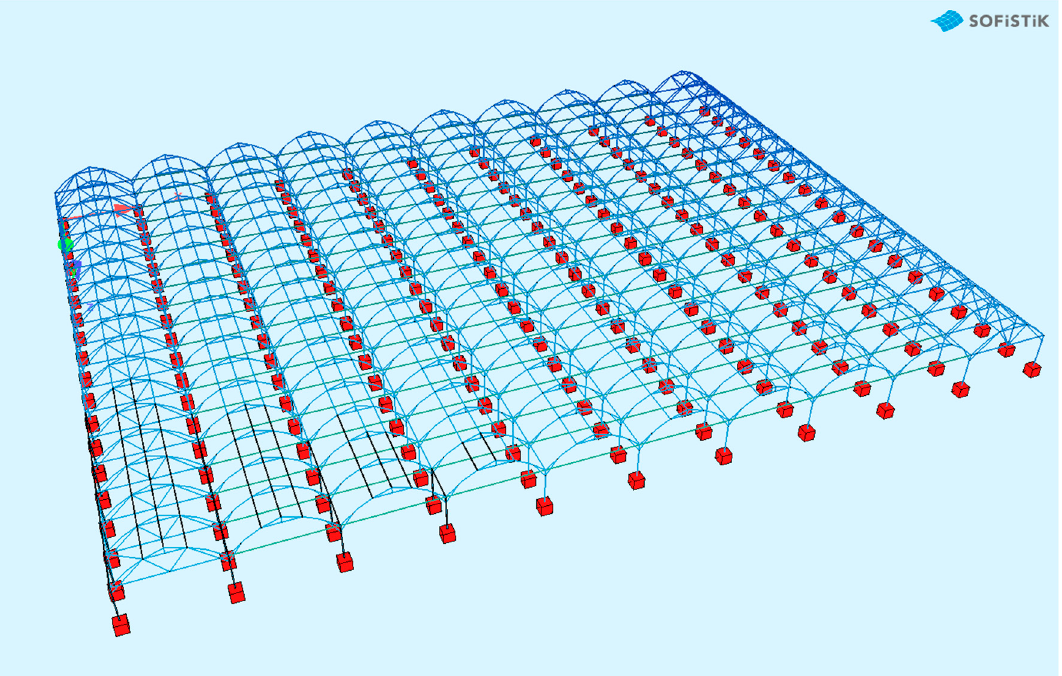
Figure 13. The three-dimensional (3D) model of the vaulted greenhouse.